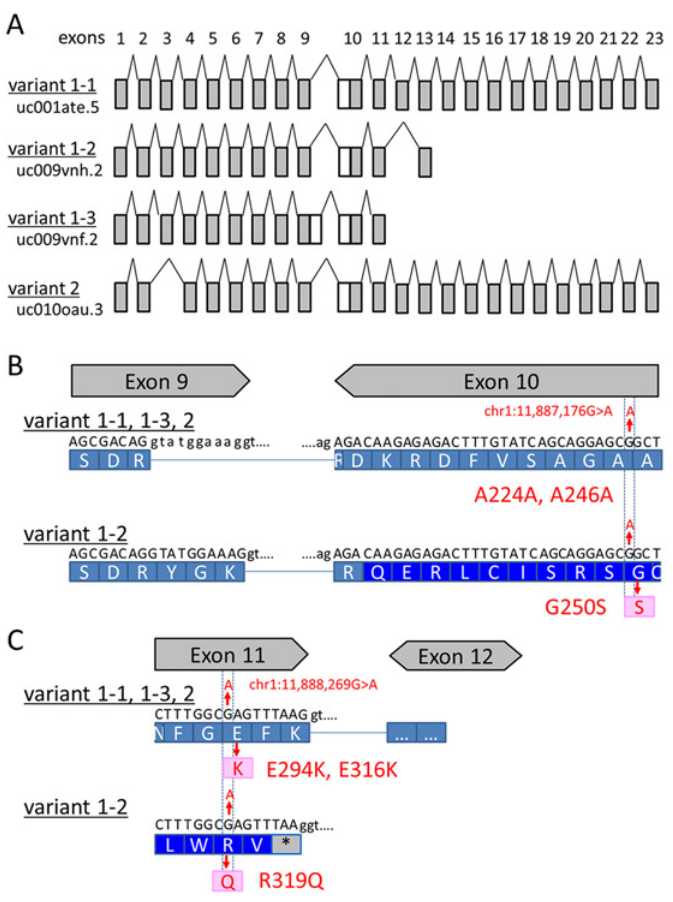
Fig 2. Exon usage and location of CLCN6 transcript variants. (A) Exon usage of four coding transcript variants. (B) Schematic representation of the locations of the SNVs identified in this study for each CLCN6 transcript variant. Two exon-intron boundaries are highlighted to clarify the complicated exon usage in the